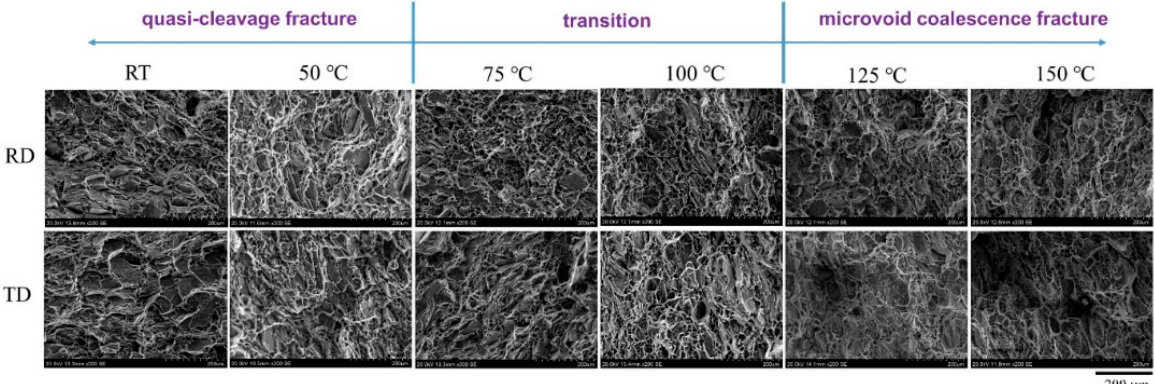
Figure 7. Fracture surface morphology.